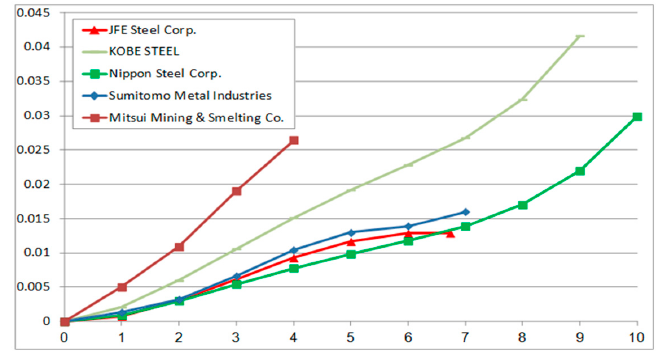
Figure 16. TSDPs of metal (steel/nonsteel/mining) industry.